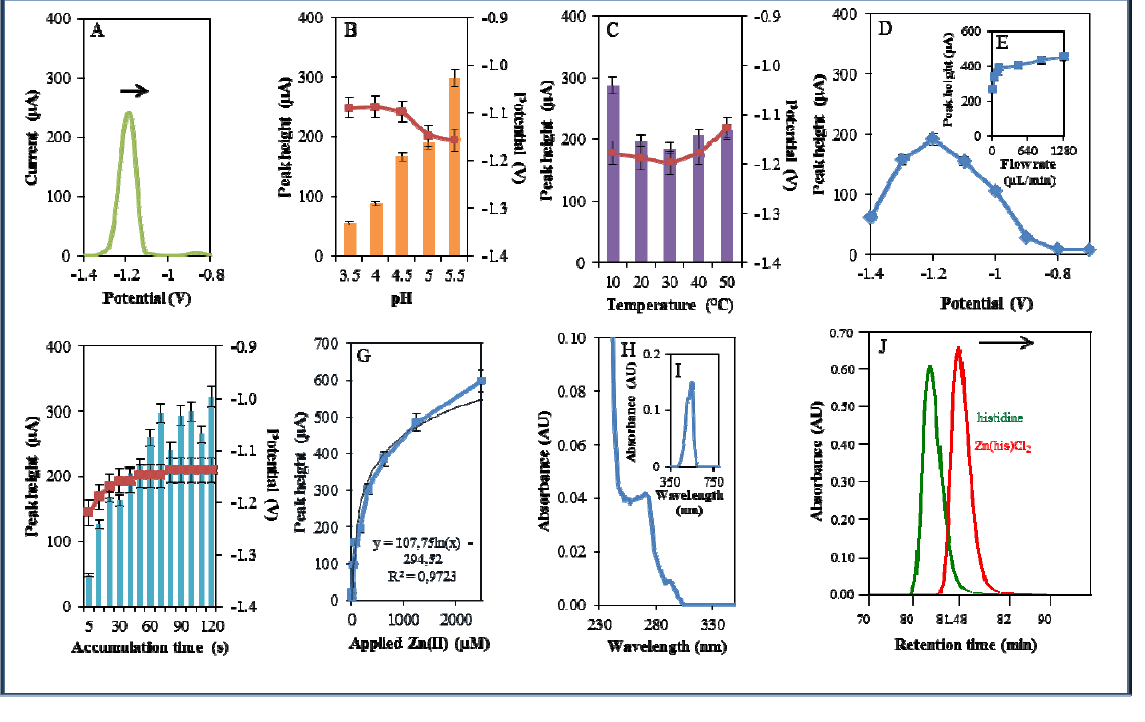
Figure 6. Electrochemical, spectrophotometric and chromatographic analysis of Zn(his)Cl complex. Basic parameters were 200 µM Zn(phen)(his)Cl temperature 20 °C unless stated otherwise. Electrochemical analysis of the Zn(his)Cl complex using differential pulse voltammetry (DPV). ( A ) DP Zn(his)Cl The effect of ( B ) pH (3.5–5.5), ( C ) temperature (10–50 °C), ( D ) applied potential ( − 1.4– − 0.6 V), ( E ) applied flow rate (0–1,280 µL/min), ( F ) time of accumulation (5–120 s), and ( G ) Calibration curve of Zn (II) ions using DPV, dependence of used concentration of Zn(II) ions in the complex (1–2,500 µM) on the change of reduction signal. In Figures B , C , and F , the blue columns represent height of signals (peaks, left scale), red squares indicate the potential at which the height of signals was detected (right scale). Spectrophotometric and chromatographic analysis of the Zn(his)Cl